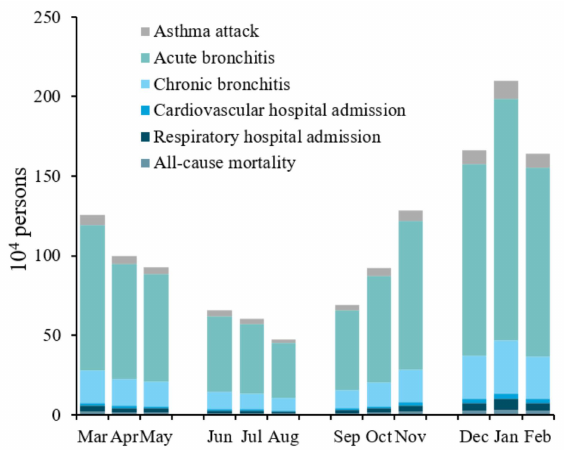
Figure 3. Health impact assessment due to PM 2.5 exposure by month in